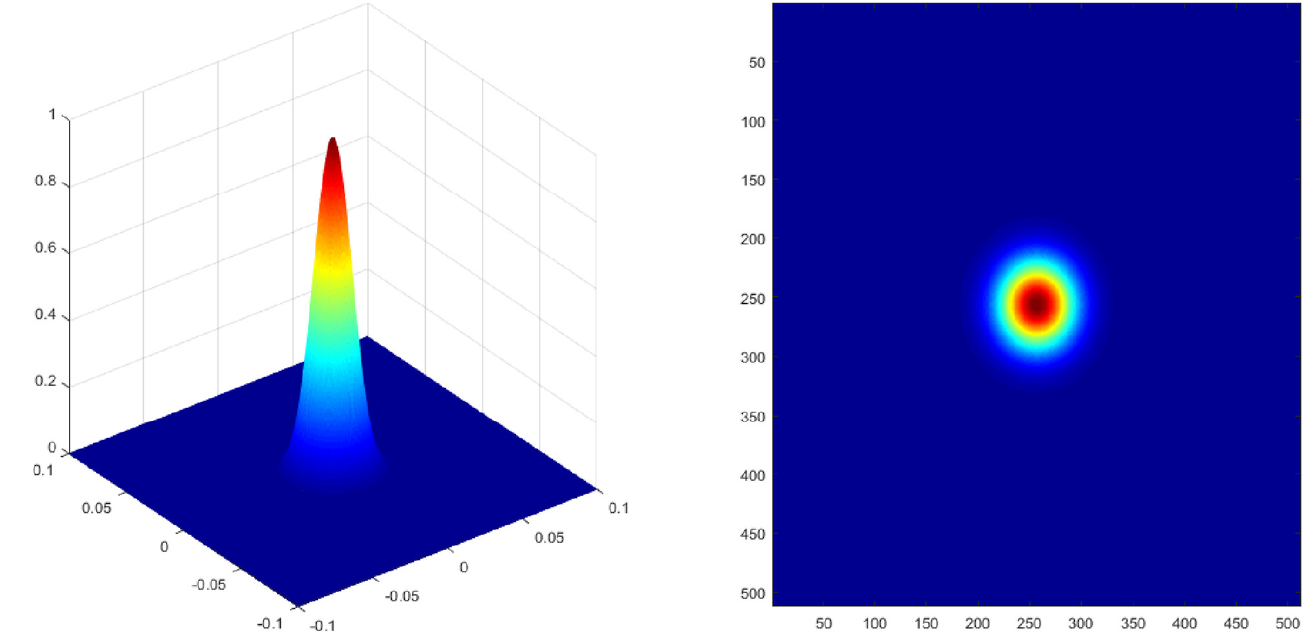
Figure 3. The three-dimensional ( left ) and two-dimensional ( right ) schematic diagrams of the emitted beam intensity distribution of the Mie lidar system at z = 0.